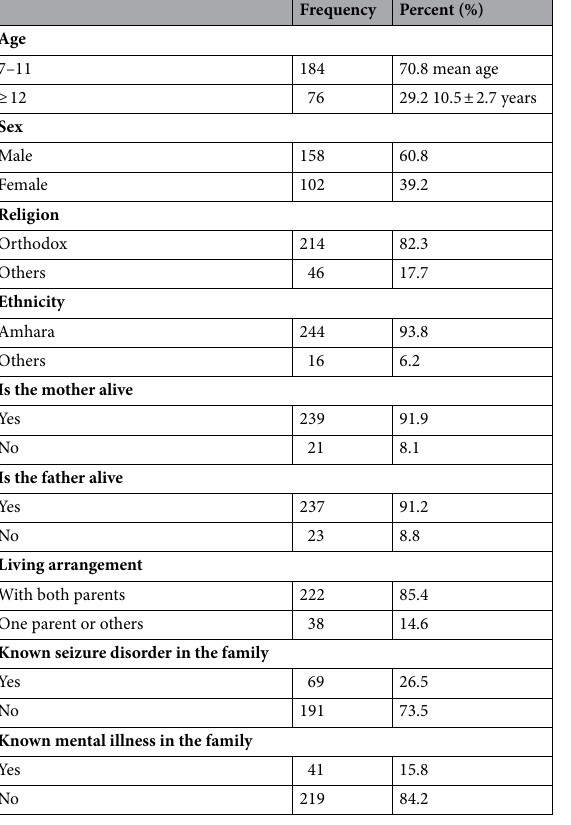
Table 1. Socio-demographic and family-related characteristics of participants (n = 260), University of Gondar referral